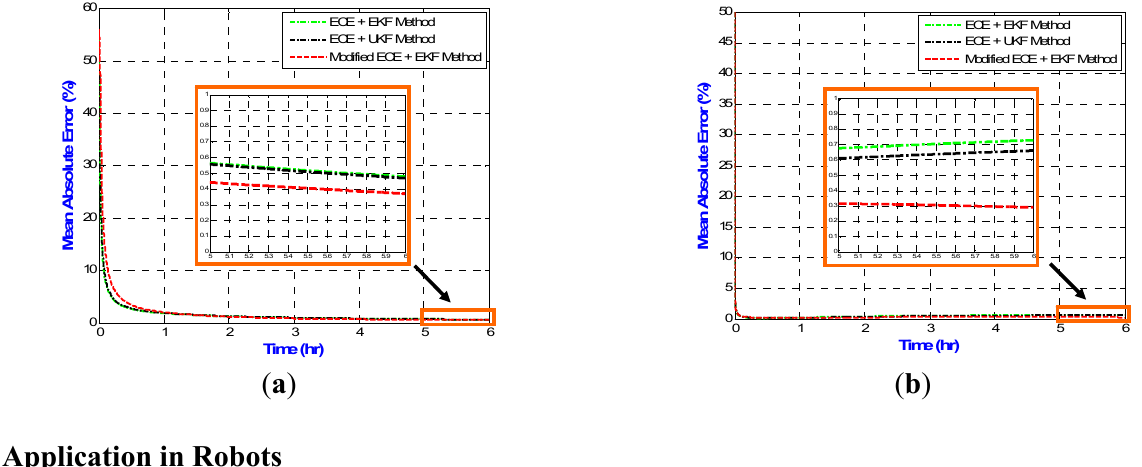
Figure 18. MAE error results in Experiment II. ( a ) Discharge; ( b )